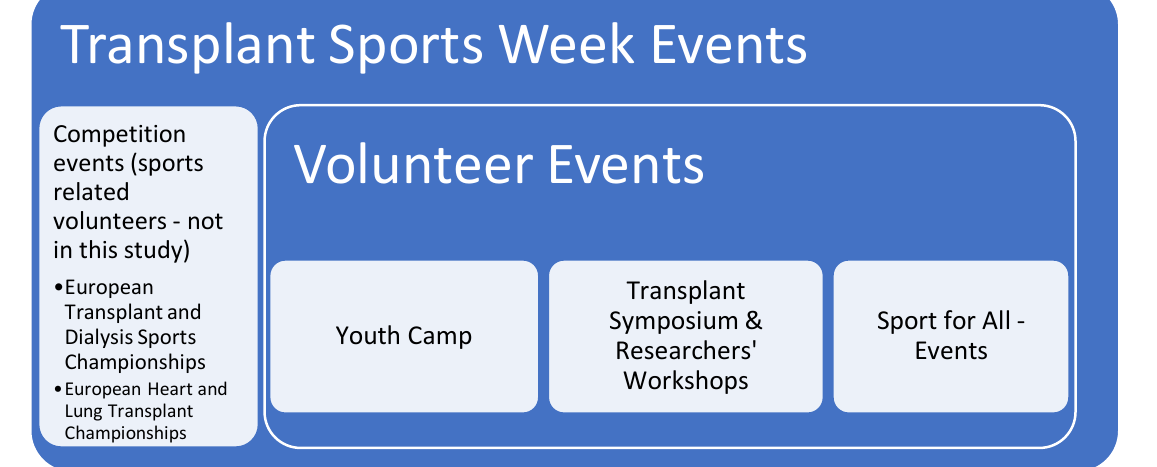
Figure 1. Overview of Volunteer Involvement in the European Transplant Sports